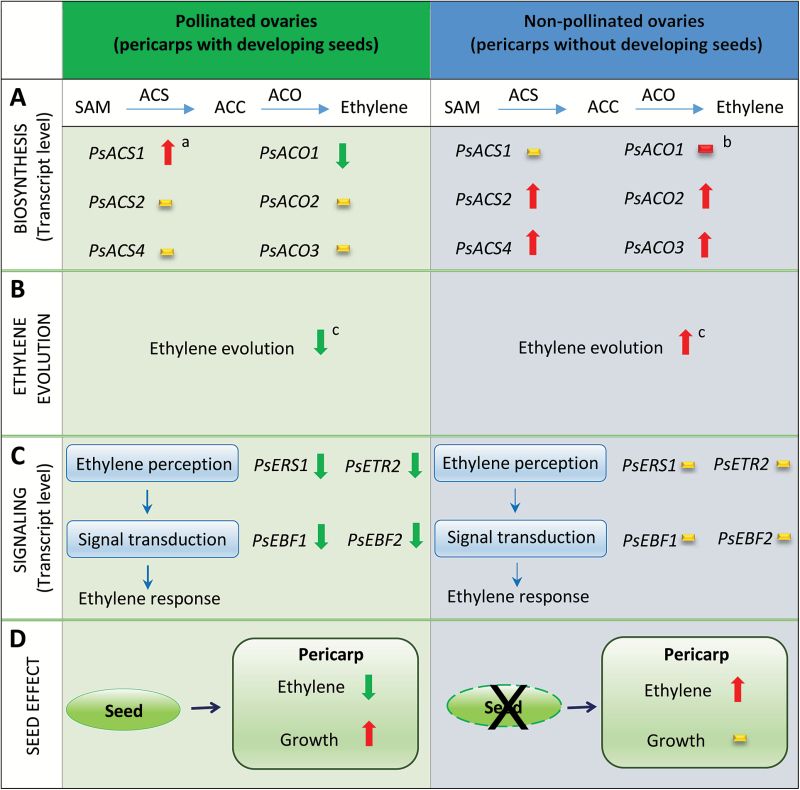
Working model of the effect of developing seeds on ethylene biosynthesis (A and B) and response (C) in pea pericarp tissue from pollinated and non-pollinated ovaries (D). Arrows show an increase (red) and decrease (green) of a given target or response. Minimal to no response is represented by a yellow dash. aPrimarily in ventral vascular suture; btranscript abundance remained relatively stable in the ventral vascular suture (red dash); cas reported by Orzáez et al. (1999).